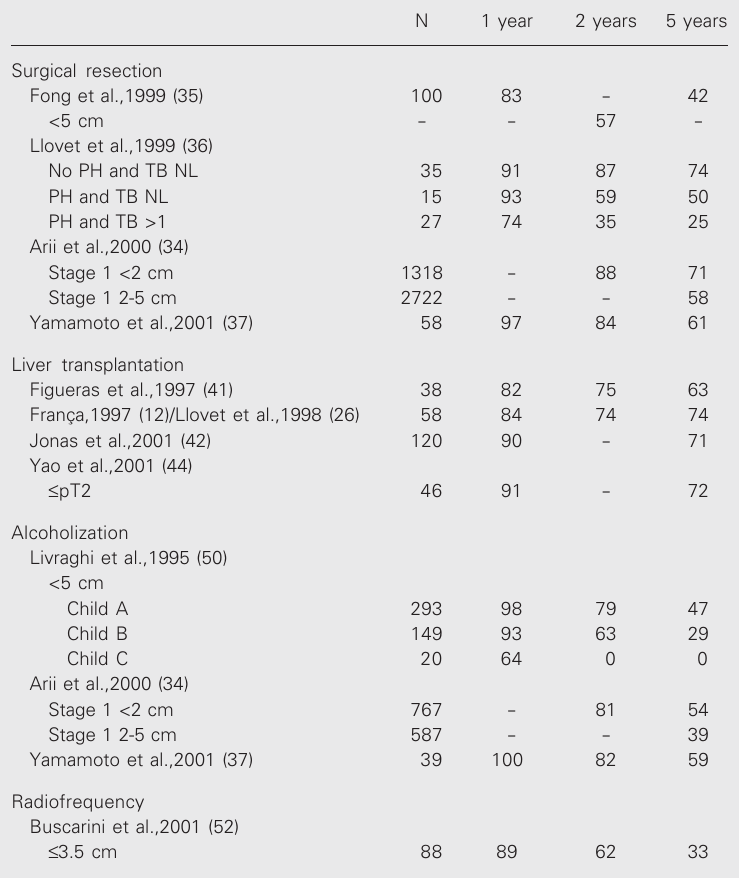
Table 7. Survival after radical treatment of hepatocellular carcinoma.